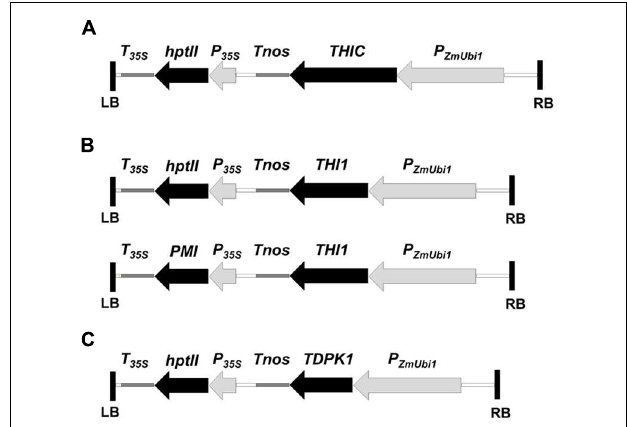
FIGURE 2 | Plant transformation vectors for the overexpression of THIC (A), THI1 (B), and TDPK1 (C). The coding sequences of THIC , THI1 , and TDPK1 were cloned downstream of the maize ubiquitin-1 promoter ( P ZmUbi 1 ) and upstream of the nopaline synthase terminator ( T nos ). THIC